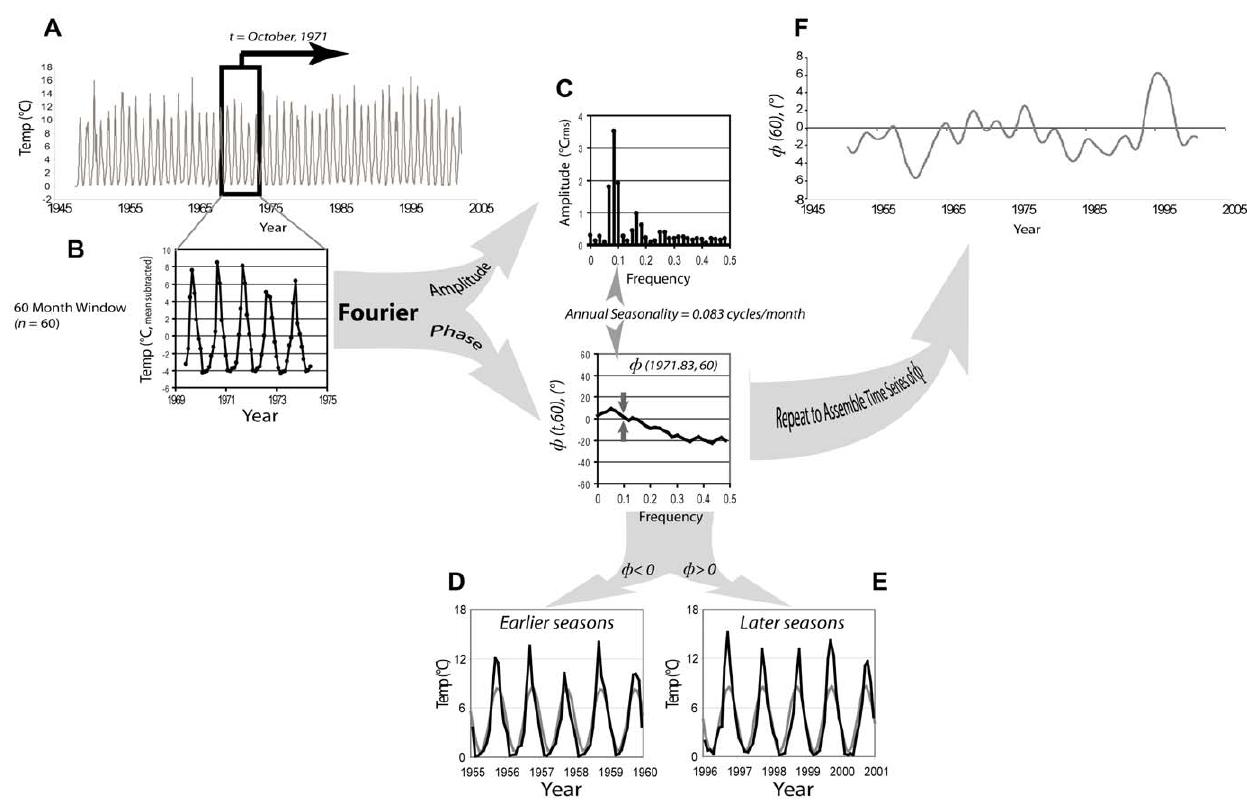
Figure 1. Workflow for estimating phase and creating a phase time series. (A) Extraction of annual seasonality anomaly ( W ( t ,n)) from long term Lake Baikal surface temperature time series. (B) The time series is mean-subtracted and then a sliding window of varying length, in this case 60 months ( n =60), is extracted sequentially as the window is passed down the length of the series. (C) At each point in time ( t ), the small window is Fourier transformed and the magnitude and phase spectra of the harmonic components are estimated. The annual seasonality is the peak at 0.083 ¯ cycles month 2 1 , and W (1971.83 ¯ ,60) is, in this example, the phase of the annual harmonic for a window 60 months long, centered at October 1971. (D and E) Time series of lake temperature (gray) compared to a single annual harmonic with a single phase estimated for the entire 58 year time series (black) to indicate the local phase anomaly, with examples of ‘‘early’’ and ‘‘late’’ seasons indicated by phase. The 60 month period 1955–1960 (D) has negative W values, indicating that lake temperature variations are advanced relative to the long term seasonality. This is observable as particularly cold Fall seasons (water temperature falling). The 60 month period 1996–2001 (E) has positive W values, indicating that lake temperature variations are delayed relative to the long term seasonality. This is observable as particularly cold Spring seasons (water temperature rising). (F) Time series of W ( t ,60) assembled by repeatedly estimating the phase of the annual harmonic as the 60 month window is passed down the data set. This time series would then be pre-whitened (noise addition) to reduce auto-correlation for cross-correlation analysis.